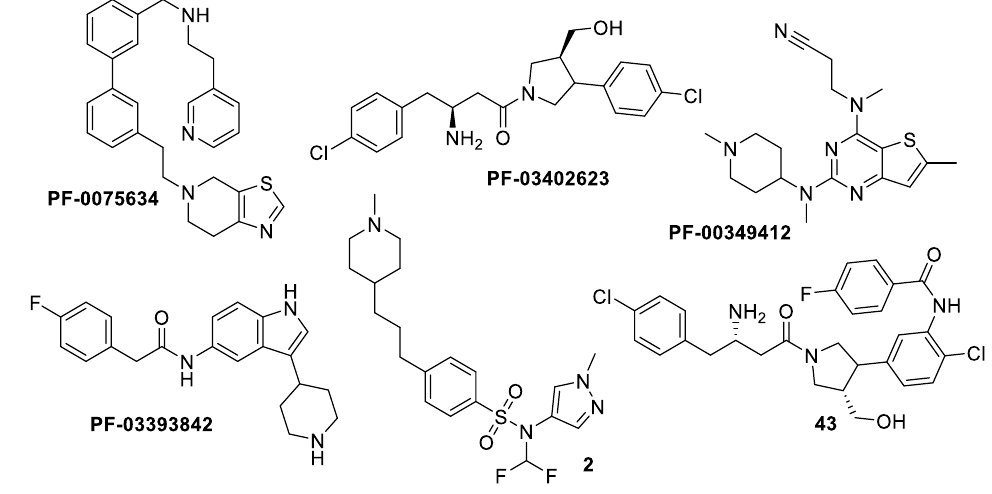
Figure 1. Structures of examples of NMT inhibitors with antileishmanial activity [9].